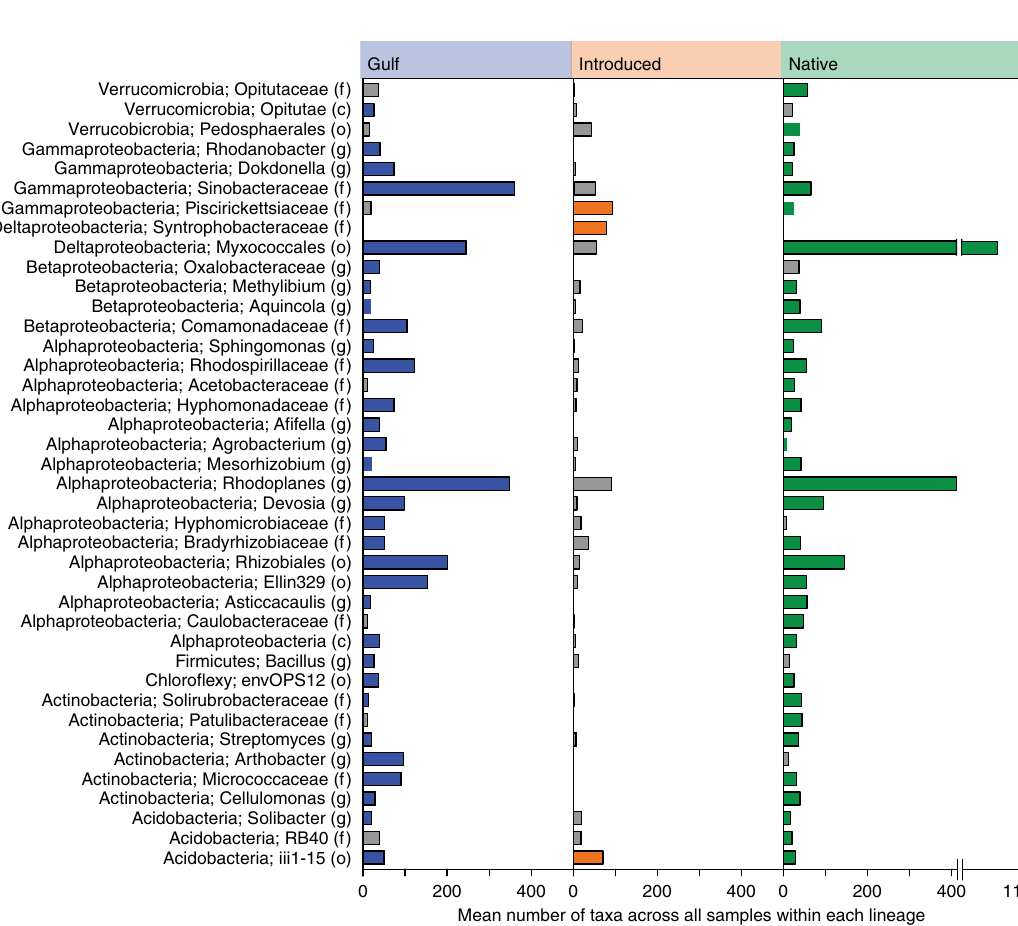
Fig. 2 Core microbiome analysis for each lineage. Abundance of taxa belonging to the core microbiome of different Phragmites australis lineages. Colored bars indicate the taxon was present in 100% of the samples for that lineage, whereas gray bars indicate that it was only present in some